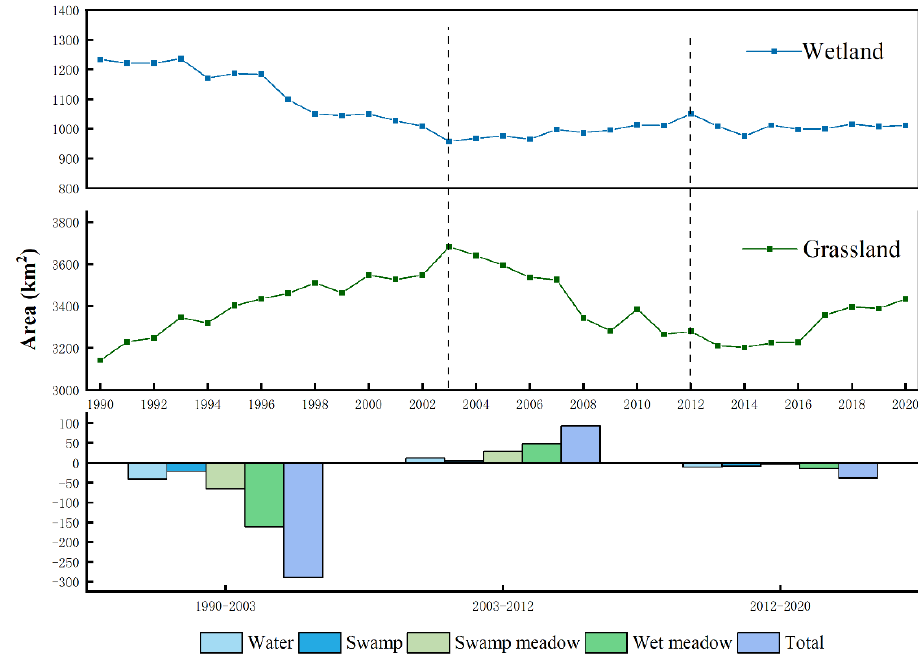
Figure 9. Changes in the areas of the wetlands and grassland during the different periods. Table 4. Areas changes (KM 2 ) in the various types of wetlands during the different periods.